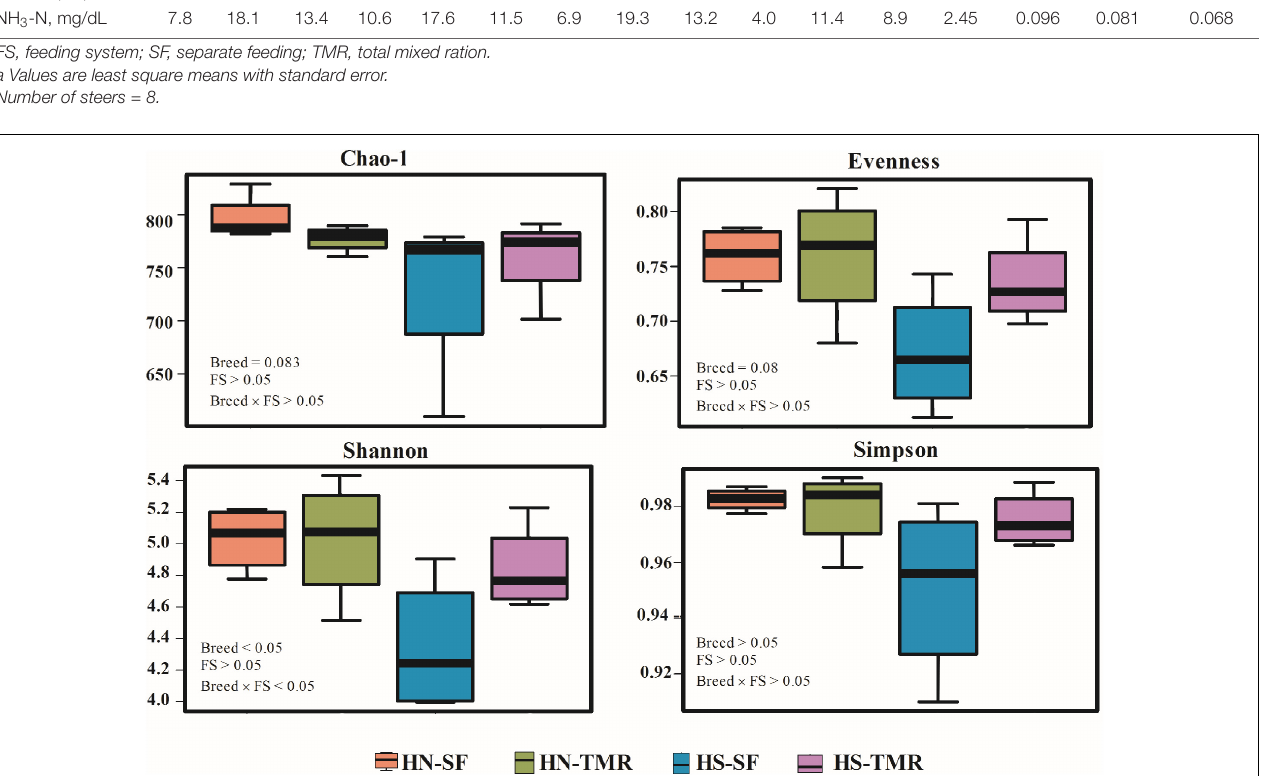
Methanobrevibacter and Sharpea , and between Anaerostipes and Butyrivibrio ( τ = − 1, P <